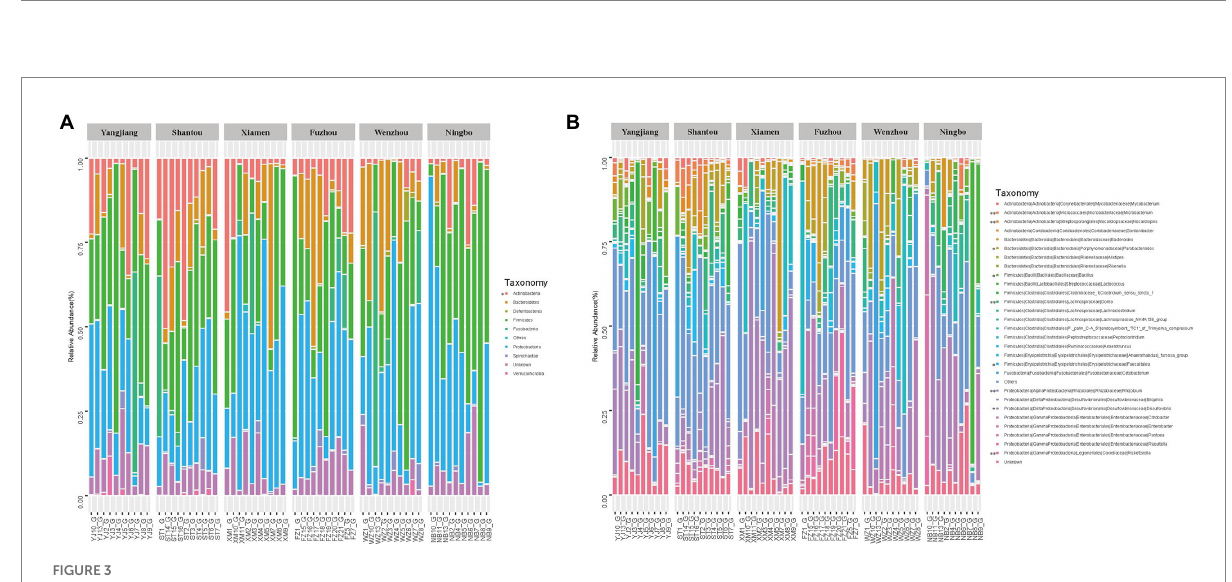
FIGURE 3 Relative contribution of gut microbiota in each sample. (A) Relative contribution in Phylum level. (B) Relative contribution in the top 30 dominant